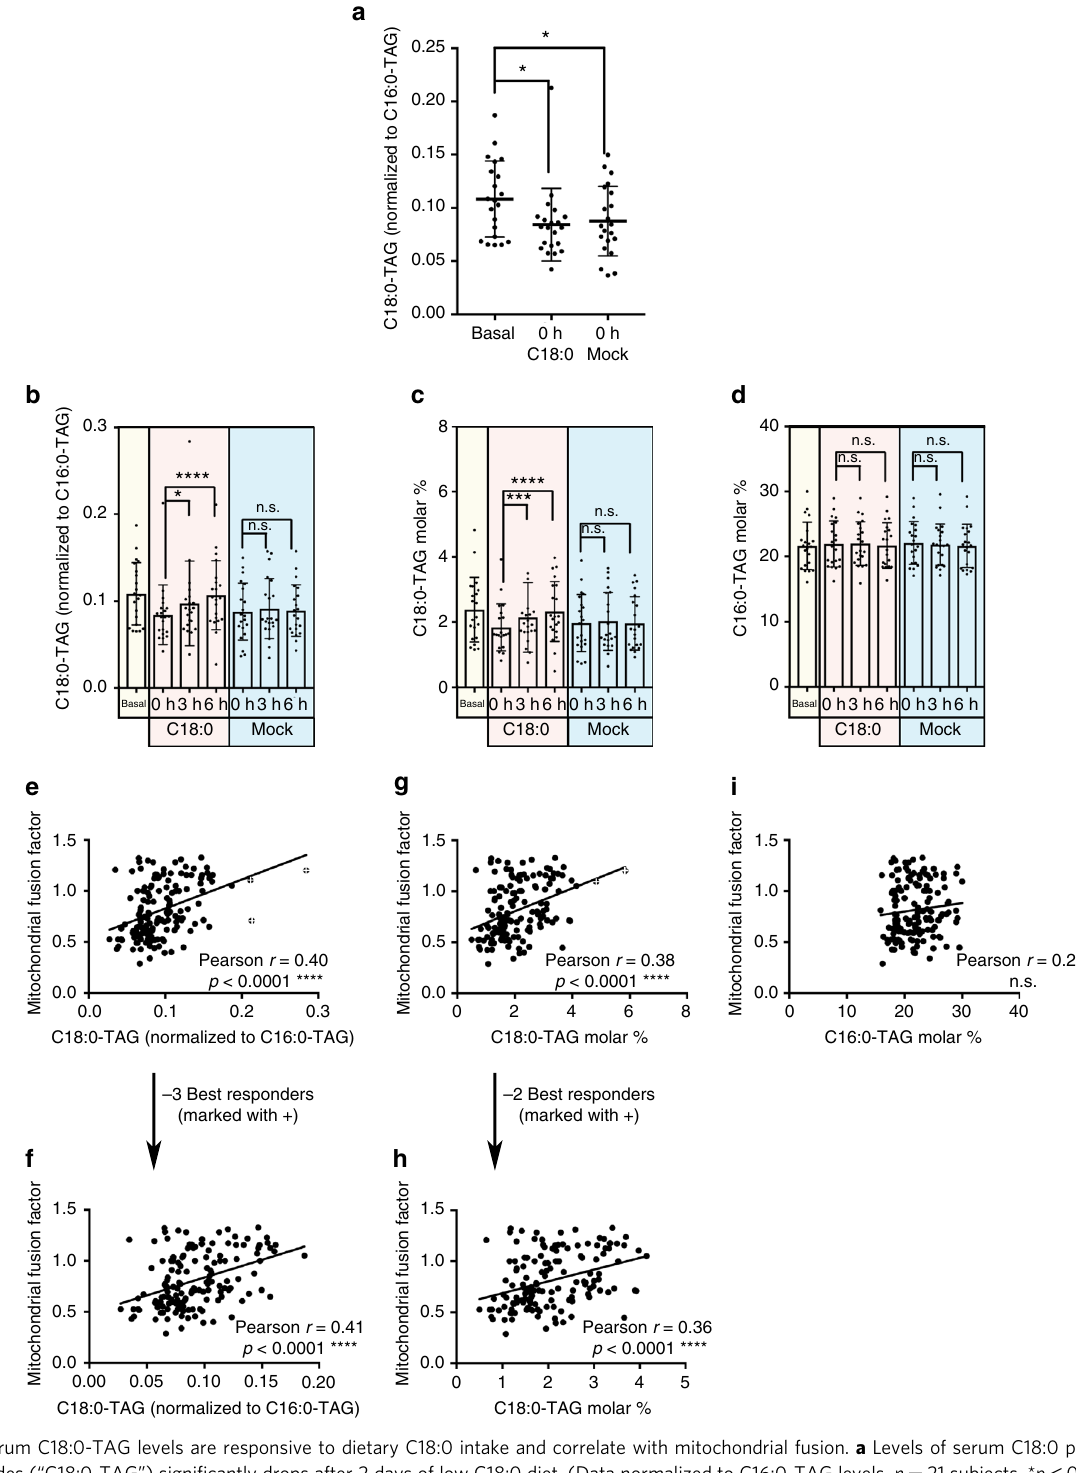
Fig. 2 Serum C18:0-TAG levels are responsive to dietary C18:0 intake and correlate with mitochondrial fusion. a Levels of serum C18:0 present in triglycerides ( “ C18:0-TAG ” ) signi fi cantly drops after 2 days of low C18:0 diet. (Data normalized to C16:0-TAG levels, n = 21 subjects, * p ≤ 0.05 by t -test.) b , c Serum C18:0-TAG levels increase after consuming the C18:0 drink but not the mock drink. b C18:0-TAG normalized to C16:0-TAG, since C16:0 is abundant and circulating levels are stable. c Molar percentage C18:0-TAG. ( n = 21 subjects, error bars = std. dev. * p ≤ 0.05, *** p ≤ 0.001, **** p ≤ 0.0001 by t -test) d C18:0 intake does not affect C16:0-TAG levels. ( n = 21 subjects, error bars = std. dev.) e – i Mitochondrial fusion in neutrophils correlates with serum C18:0-TAG levels ( e – h ) but not C16:0-TAG levels ( i ) across all subjects, timepoints, and dietary conditions. ( n = 21 subjects× 7 timepoints